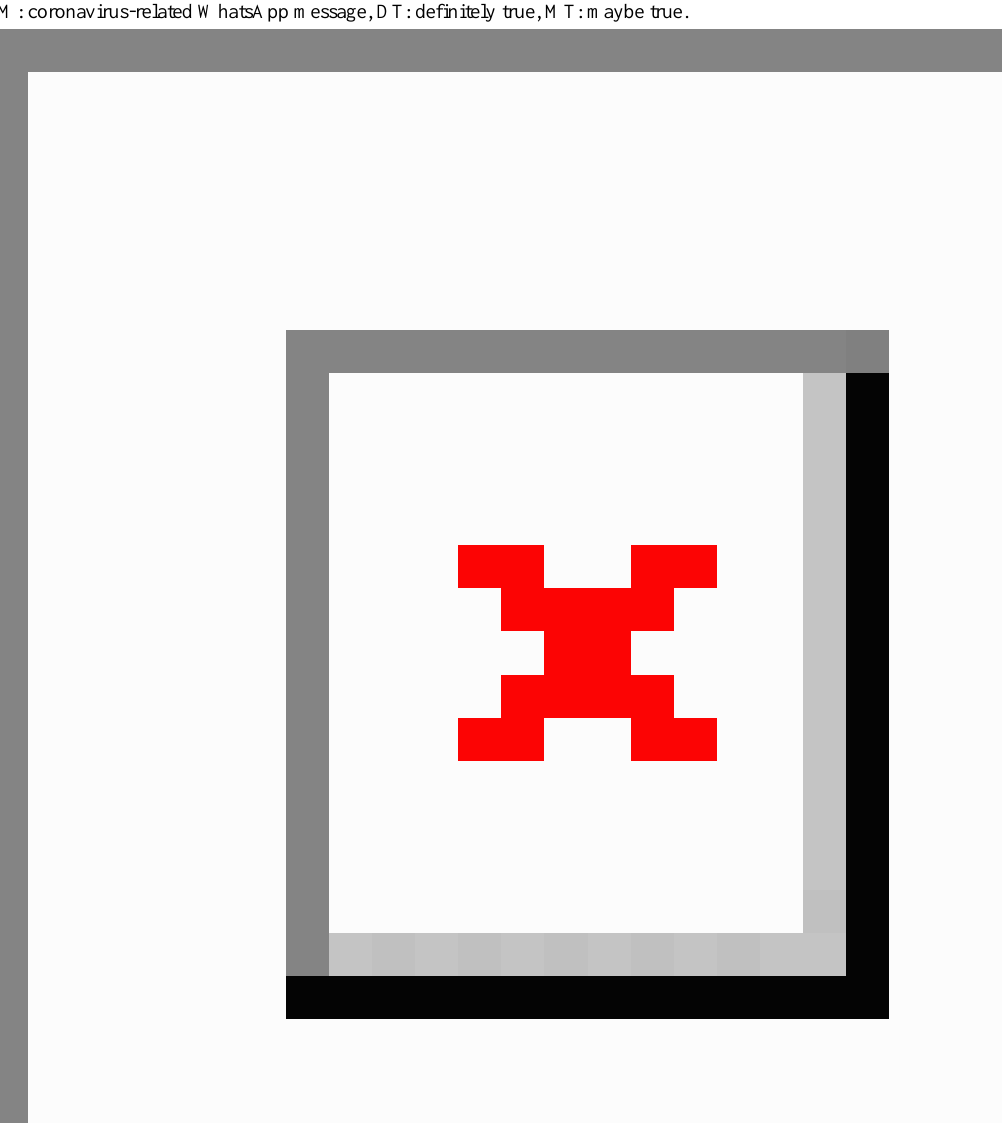
Figure 3. Number of times a false CRWM was marked as true for every false CRWM with and without background evidence (link and/or